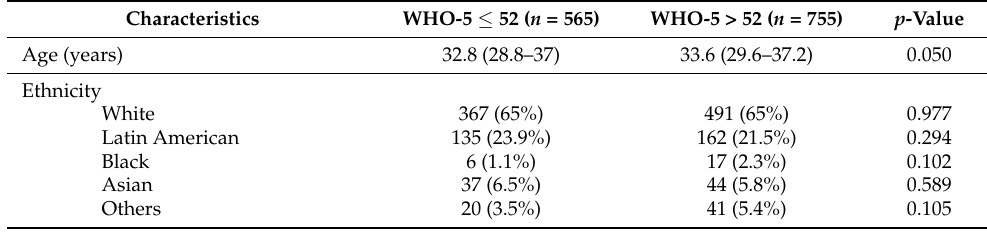
Table 3. Pandemic cohort baseline characteristics based on maternal well-being